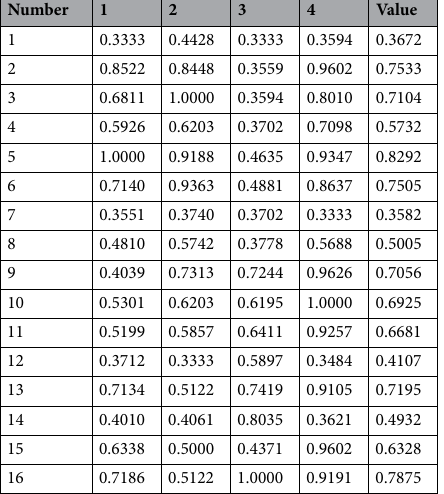
Table 8. Grey correlation degree of comprehensive